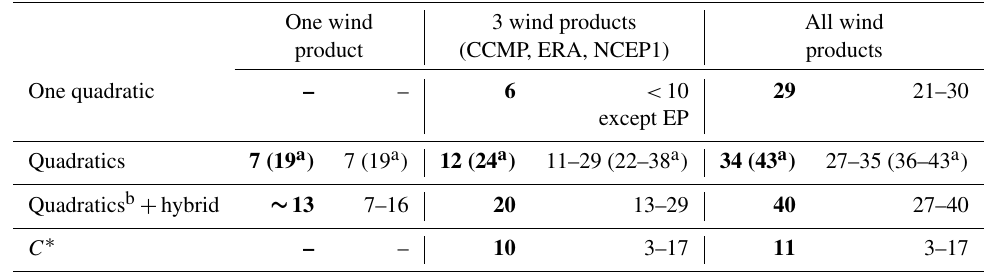
Table 3. Relative difference in F CO 2 between the highest and lowest F CO 2 obtained using different combinations of wind products and k formulations expressed in percent. Results are calculated globally (numbers in bold) and regionally (minimum and maximum relative difference between all RECCAP regions results). Note that the RECCAP regions 2 and 3 (Equatorial Pacific, EP) have been merged. C ∗ represents F CO 2 calculated with a quadratic k relationship where c is recalibrated for each wind product to fit a global average k value of 16cmh − 1 for the period of our study